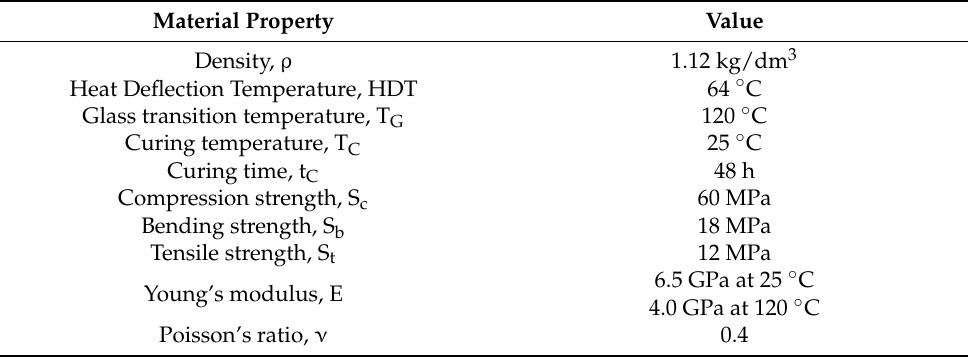
Table 2. Main physical properties of polymer.